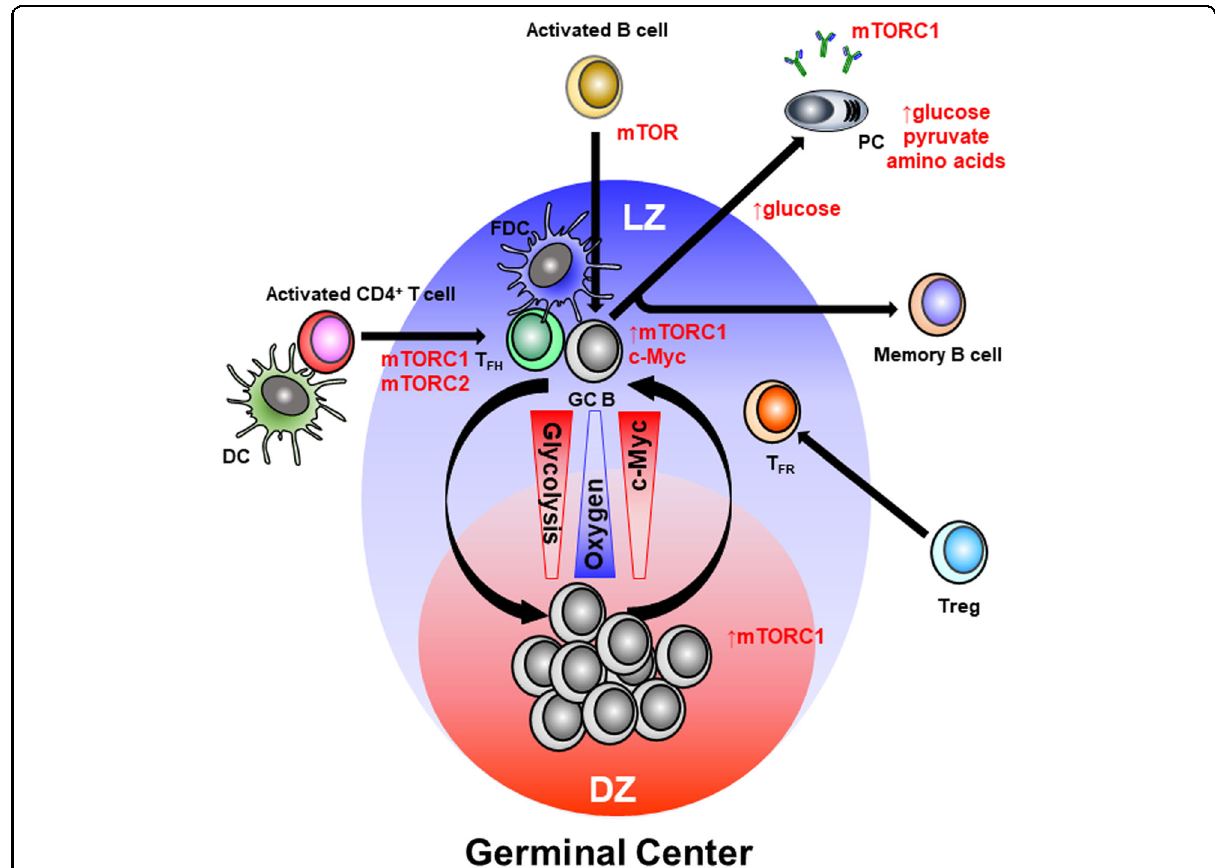
Fig. 2 Overview of the major metabolic regulators in the GC. Activated B and CD4 + T cells migrate into the GC to differentiate GC B and T FH cells through mTOR activation. LZ GC B cells are more glycolytic and show higher c-Myc expression than DZ GC B cells, which is correlated with their lower oxygen consumption in the LZ hypoxic environment. PCs continuously utilize glucose, which is the main energy source during B-cell activation, as well as pyruvate and amino